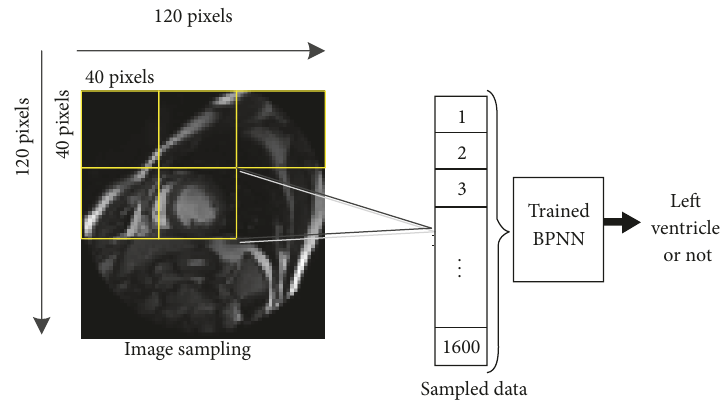
Figure 6: Sampling of image for left ventricle detection using trained